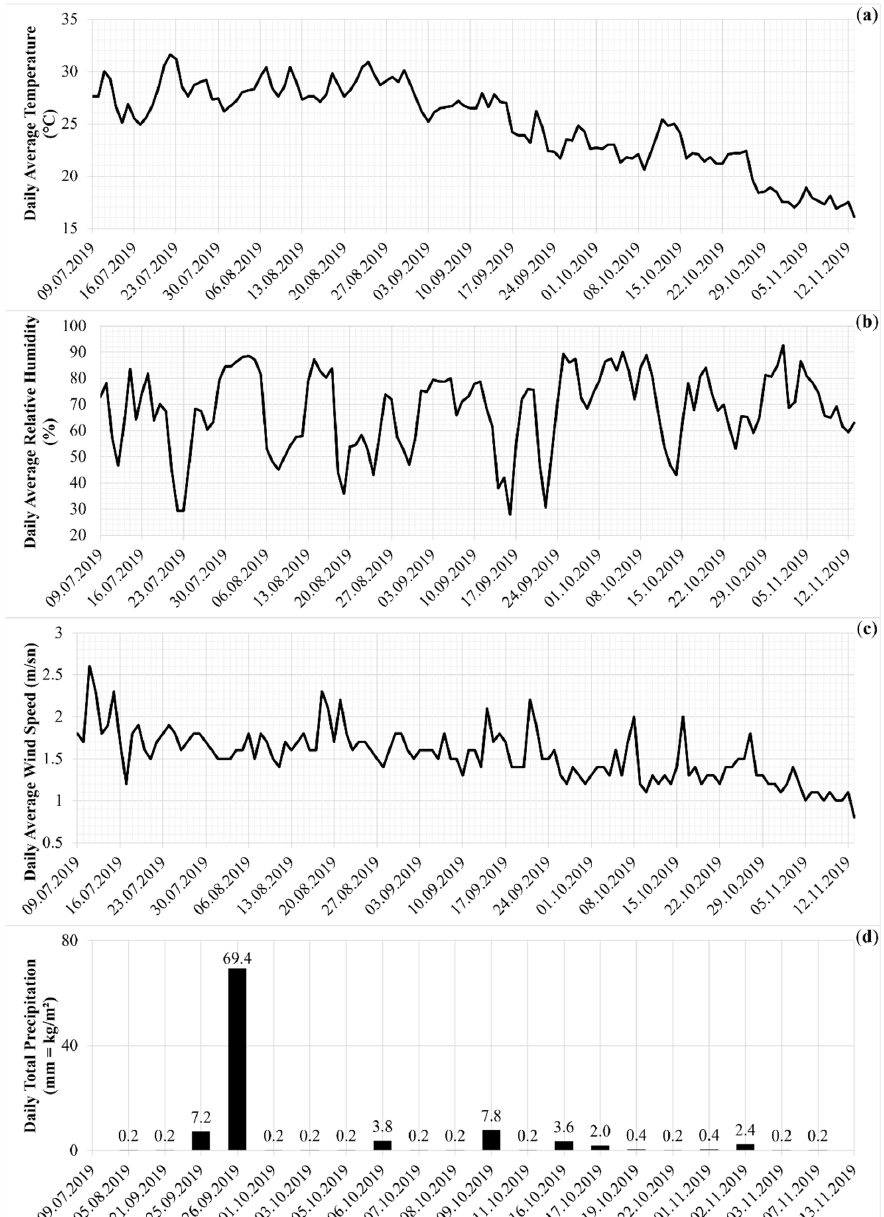
Figure 4. Meteorological data: ( a ) daily average temperature (°C); ( b ) daily average relative humidity (%); ( c ) daily average wind speed (m/s); ( d ) daily total precipitation (mm = kg/m 2 ).